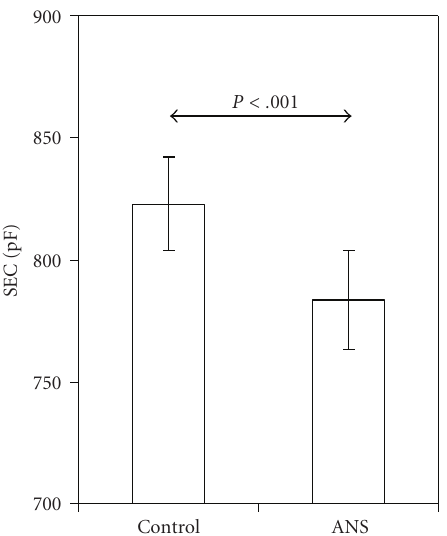
Figure 3: Wet/dry weight ratio (W/D) is lower in the skin of embryonic day 18 rat pups exposed to antenatal corticosteroids (ANSs; n = 7) than in skin of unexposed controls (Control; n = 8). Values are presented as means ± SD.